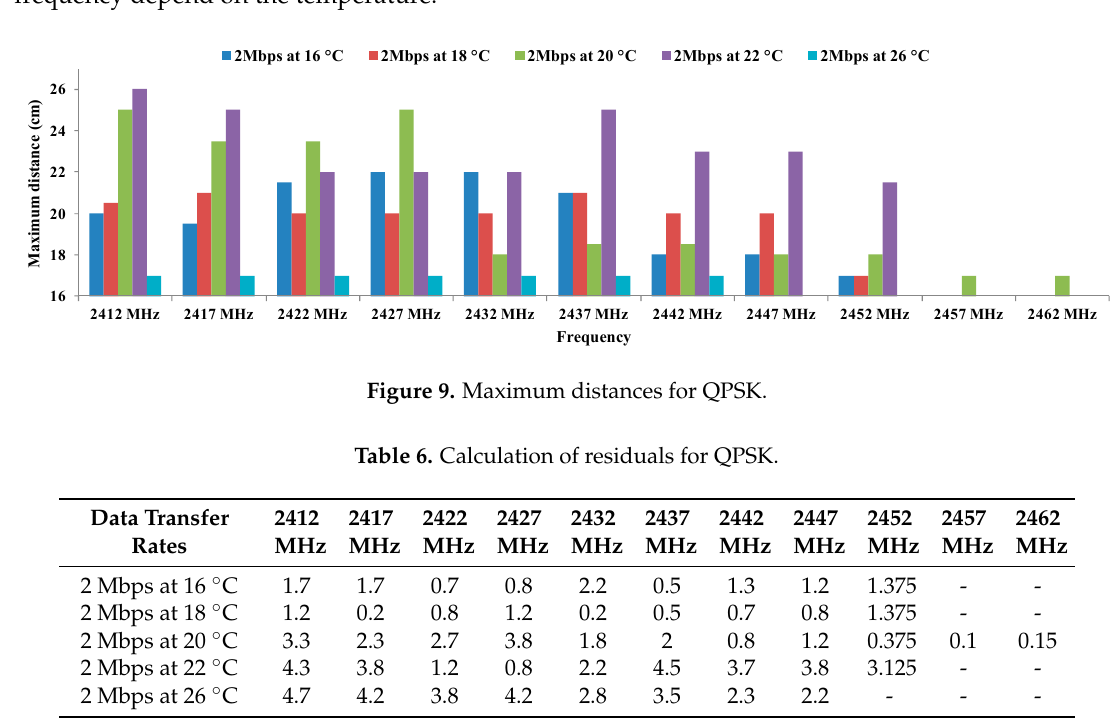
Table 5. ANOVA for BPSK. Origin of Variations